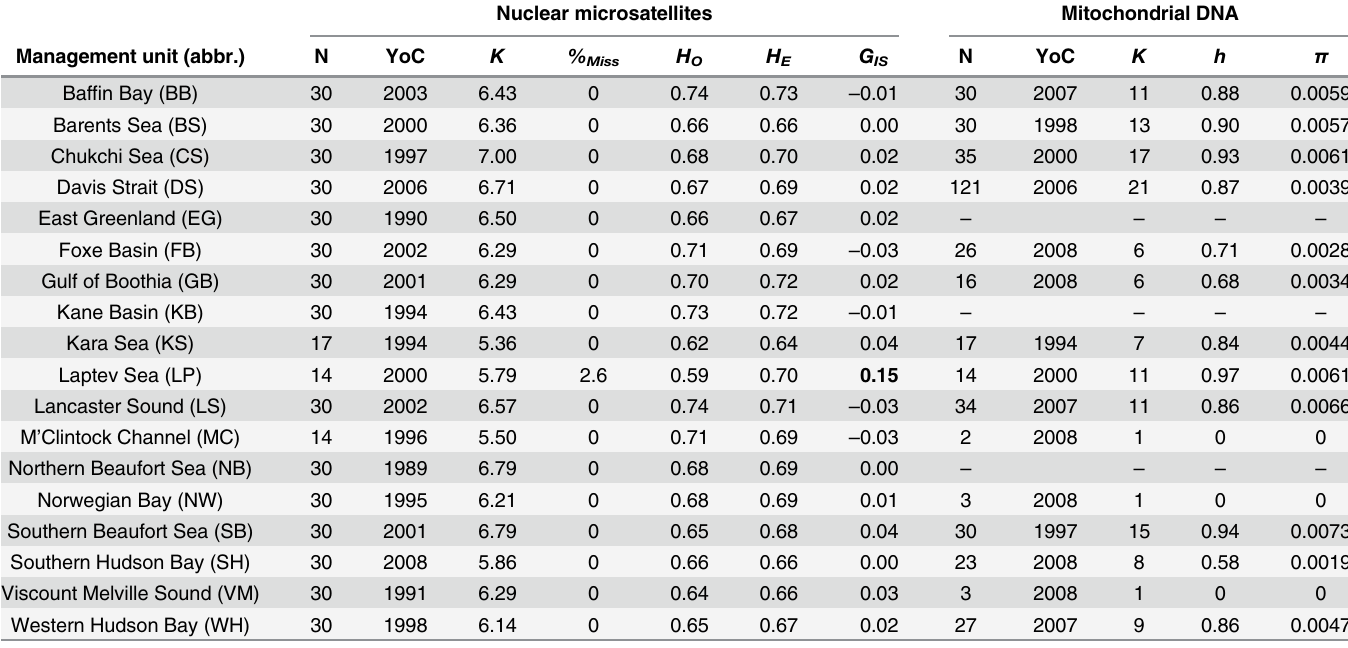
Table 1. Genetic diversity statistics for 18 management units of polar bears. For microsatellite data, a maximum of 30 individuals have been retained from each management unit from the original dataset of 2,748 individuals, and only the 14 loci indicated in Fig 1 have been used. Molecular diversity indices for mitochondrial DNA were calculated in A RLEQUIN using pairwise differences with no gamma